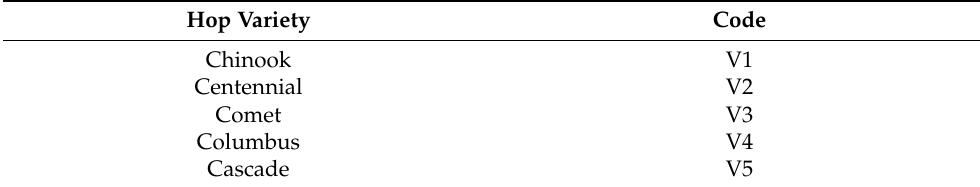
Table 1. List of samples analyzed. Hop Variety